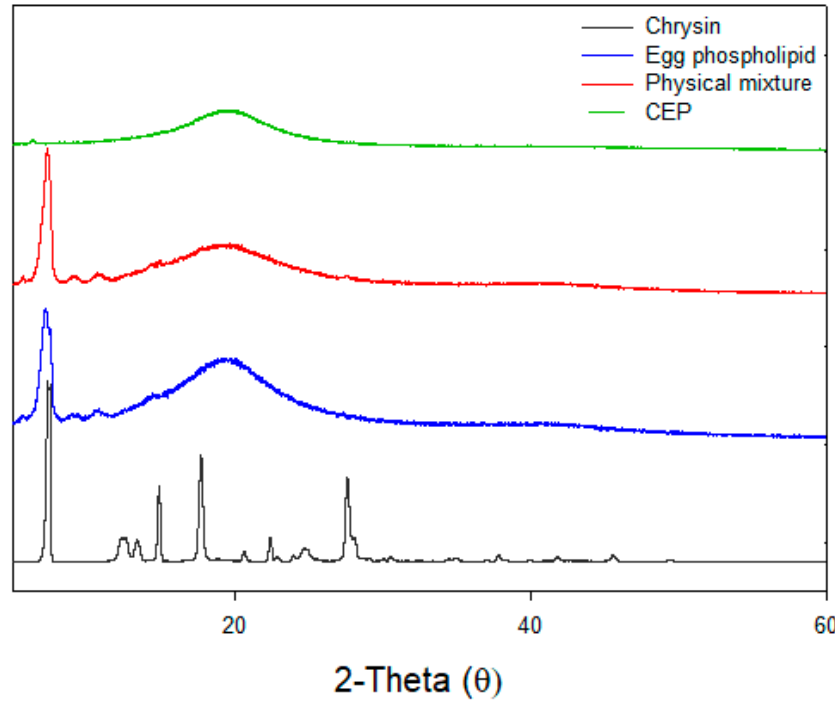
Figure 4. X-ray diffractograms of chrysin, egg phospholipid, physical mixture and CEP-1:3.